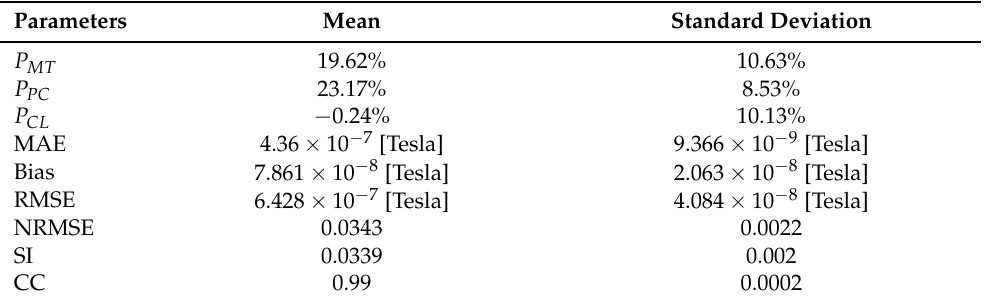
Table 4. Mean and standard deviation of the parameters used for comparison for the entire MC runs.